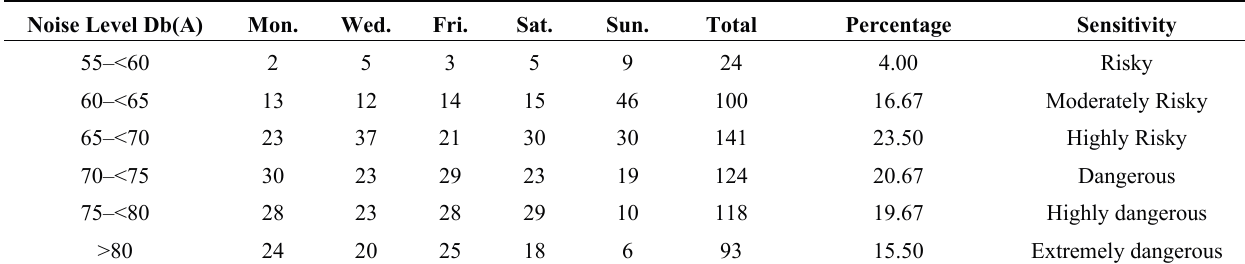
Table 5. Percentile distribution of the recorded average noise